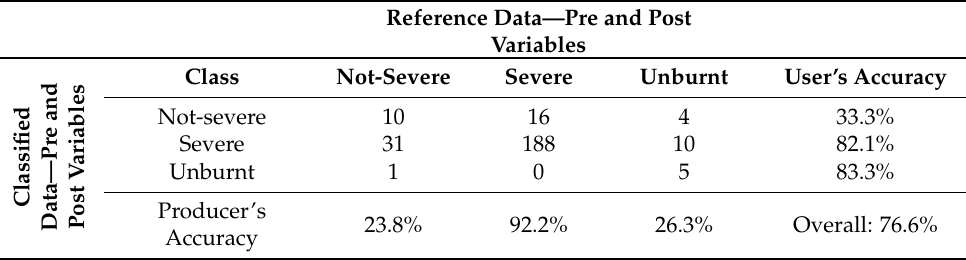
Table 10. Confusion matrix for Combined stream describing severity of sedgeland